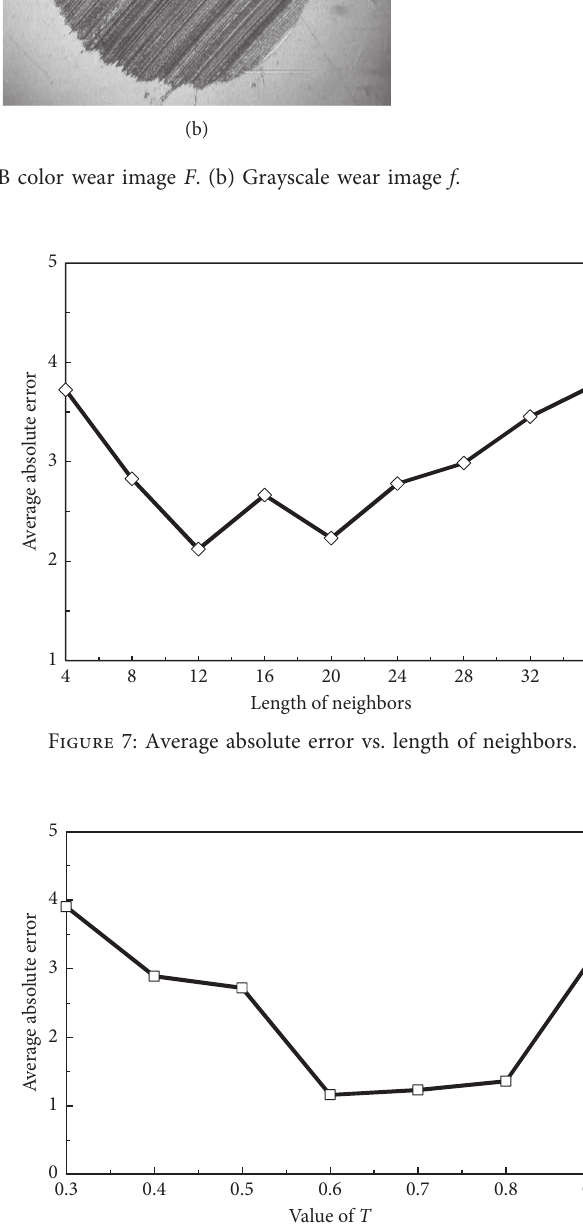
Figure 8: Average absolute error vs. value of T